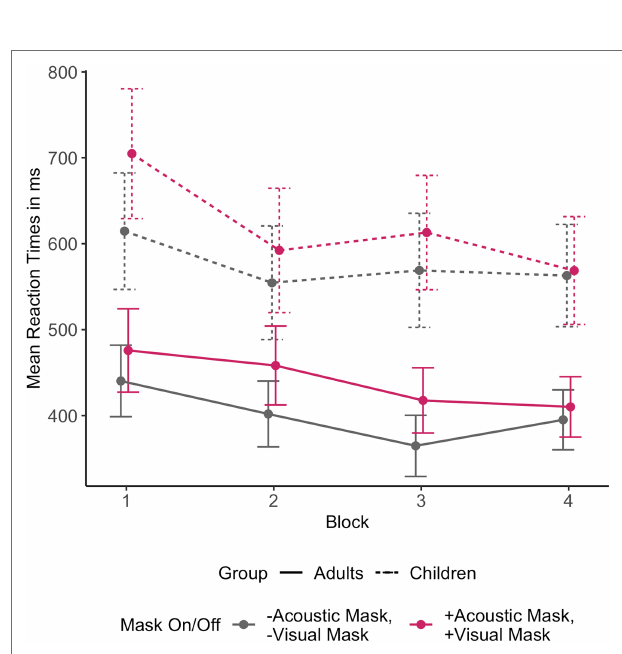
FIGURE 6 | Mean reaction times across the four experiment blocks by Age Group based on the raw data, comparing fully masked + Acoustic Mask, + Visual Mask and fully unmasked – Acoustic Mask, – Visual Mask